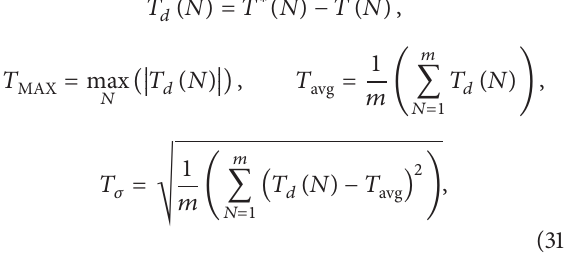
controllers are implemented in the experimentation for the comparison of the control performance. In order to